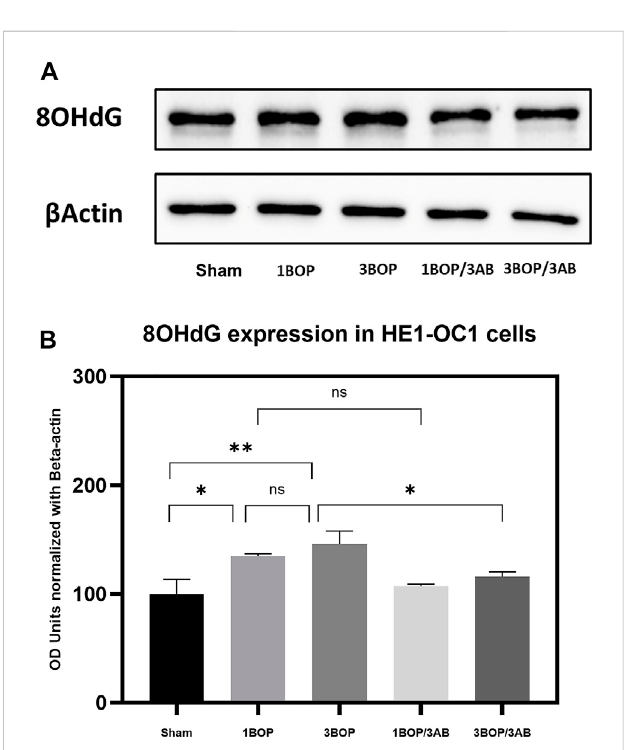
FIGURE 9 Assessment of 8-OHdG protein expressions by immunoblotting analysisinHEI-OC1afterBOPexposure. (A) Theimmunoblotsshowsthe protein expressions of 8- OHdG levels in HEI-OC1 cells. (B) The histogram shows the semi-quantitative protein expression of 8- OHdG levels in HEI-0C1 cells normalized against the internal control (3- Actin. Statistical difference between the cell groups were (* p < 0.05; ** p < 0.005) represented as Mean ± SEM ( n =